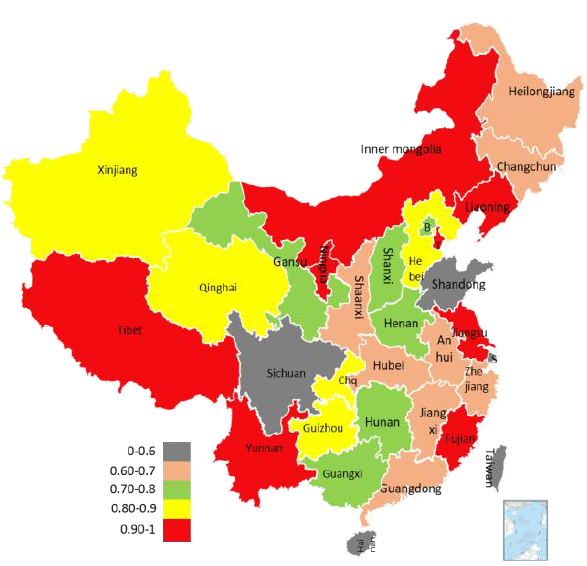
Figure 4. Investment efficiency of the third stage of China's provincial PGEs.